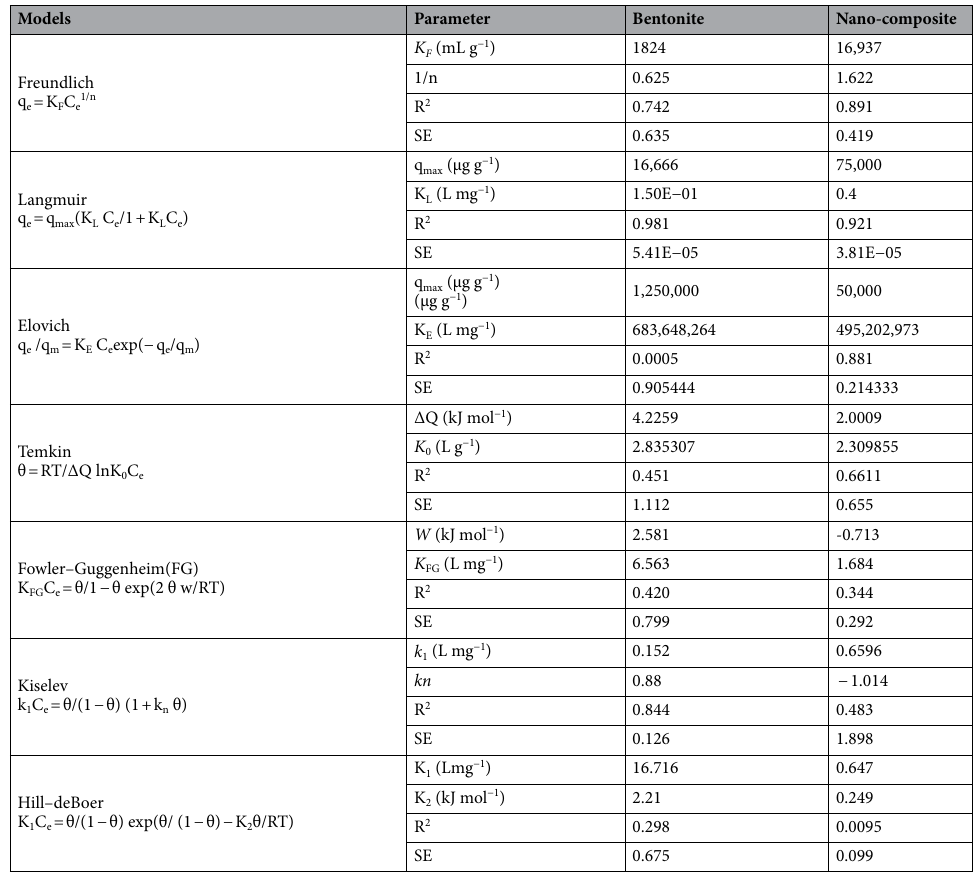
Table 2. Equilibrium model constants and determination coefficients and standard error of estimate for Pb(II) adsorption by bentonite and composite sorbents. qe (mg g −1 ) = Pb adsorbed per gram of adsorbent, Ce (mg L −1 ) = equilibrium Pb concentration in solution, K F = a constant related to adsorption capacity of the adsorbent (mL g −1 ), n = a constant, q max (mg g −1 ) is the maximum adsorption capacity of the adsorbent, KL (L mg −1 ) = Langmuir constant related to the free energy of adsorption, θ = fractional coverage, R = the universal gas constant (kJ mol −1 K −1 ), T = the temperature (K), Δ Q = (− Δ H ) the variation of adsorption energy (kJ mol −1 ), and K 0 = Temkin constant (L mg −1 ), K FG = Fowler–Guggenheim constant (L mg −1 ), w = the interaction energy between adsorbed molecules (kJ mol −1 ), k 1 = Kiselev constant (L mg −1 ), k n = a constant of complex formation between adsorbed molecules, K 1 = Hill–de Boer constant (L mg −1 ), and K 2 (kJ mol −1 ) = a constant related to the interaction between adsorbed molecules. A positive K 2 means attraction between adsorbed species and a negative value means repulsion.